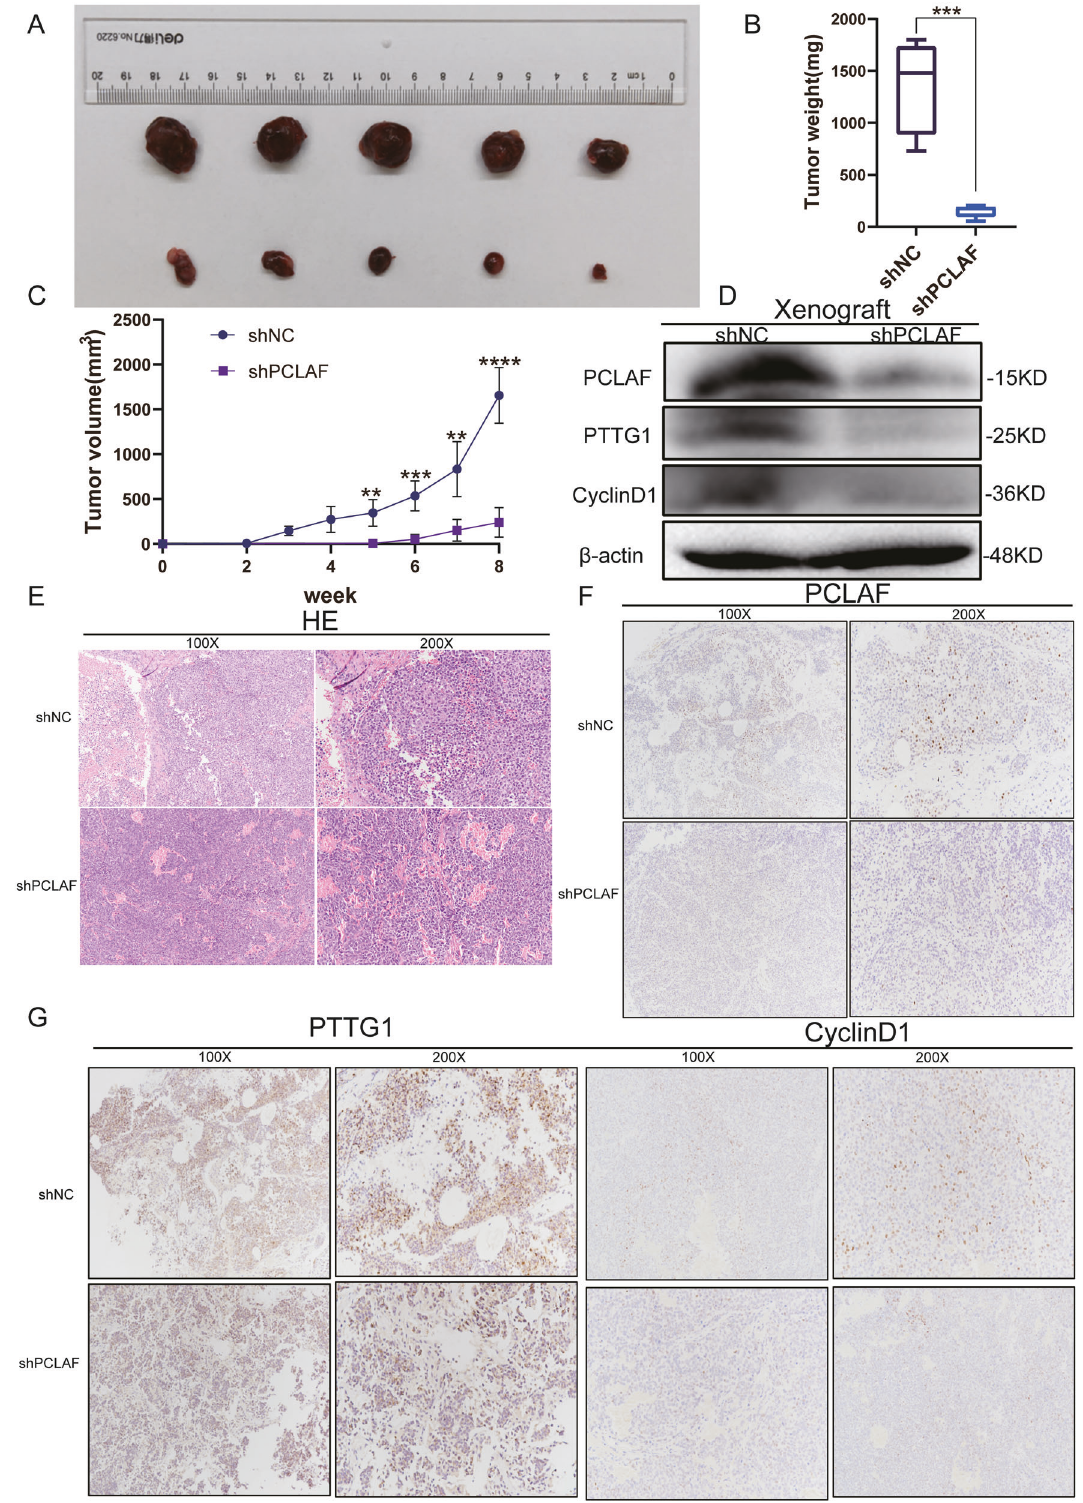
Fig. 6 PCLAF knockdown restrained the growth of neuroblastoma in vivo. ( A ) The volume of tumors obtained from xenografts was diminished in the PCLAF-knockdown group by shRNA from the SK-N-BE (2) cell line; ( B, C ) The volume and weight of tumors formed by PCLAF knockdown cells were dramatically smaller than that of the control; ( D ) The expression of PCLAF, PTTG1 and CyclinD1 were examined by western blot in tumors obtained from xenografts; ( E ) H&E staining of subcutaneous tumors in BALB/c nude mice; ( F, G ) Immunohistochemical staining of subcutaneous tumors on target of PCLAF, PTTG1 andCyclinD1 separately. (* p < 0.05, ** p < 0.01, *** p < 0.001 and **** p < 0.0001, and bar graphs represent the mean ± SEM).